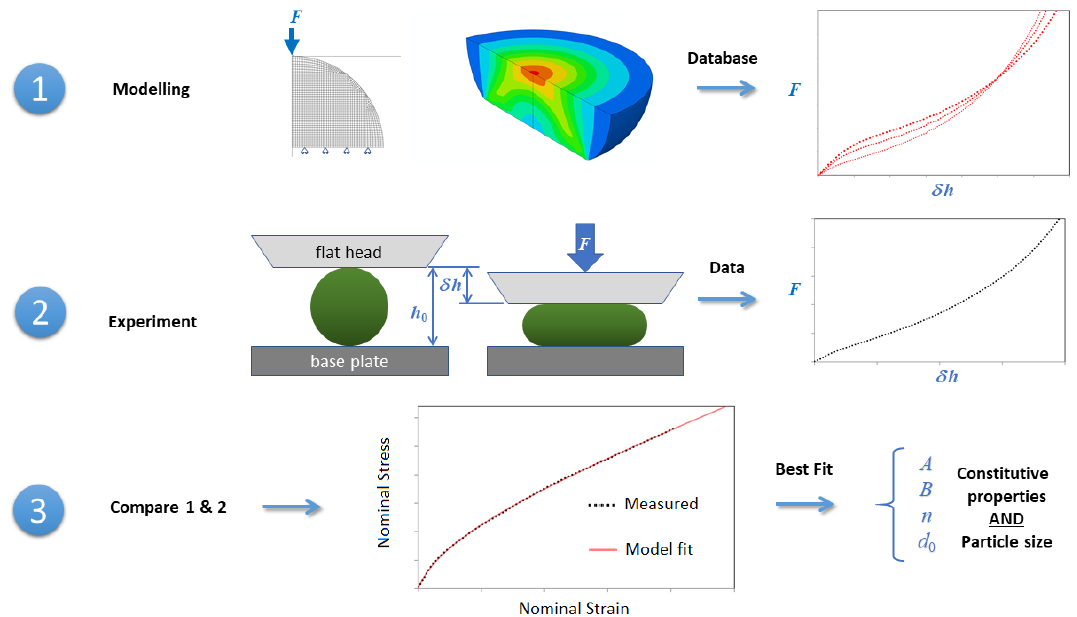
Figure 3. Flow chart of the method used to determine the constitutive properties and the size of the particles of cold-spray powders by modelling ( 1 ), experiments ( 2 ), and fitting ( 3 ).